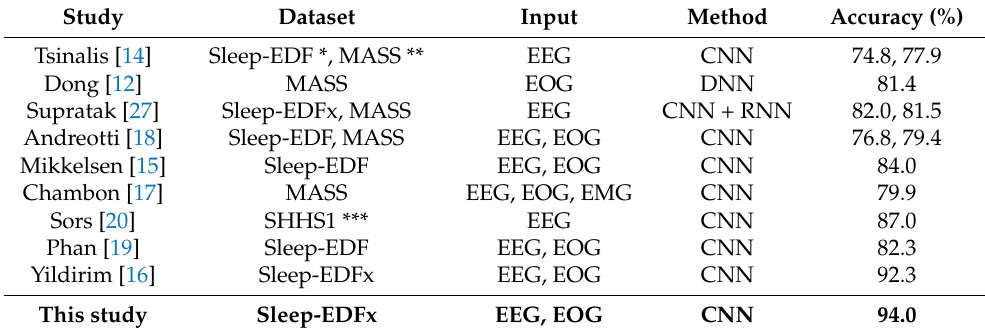
Table 6. A comparison of sleep-stage classification